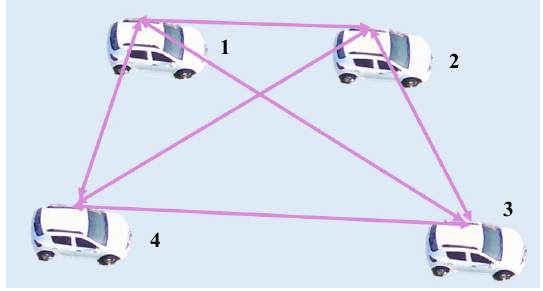
Figure 1 . Collaborative navigation concept